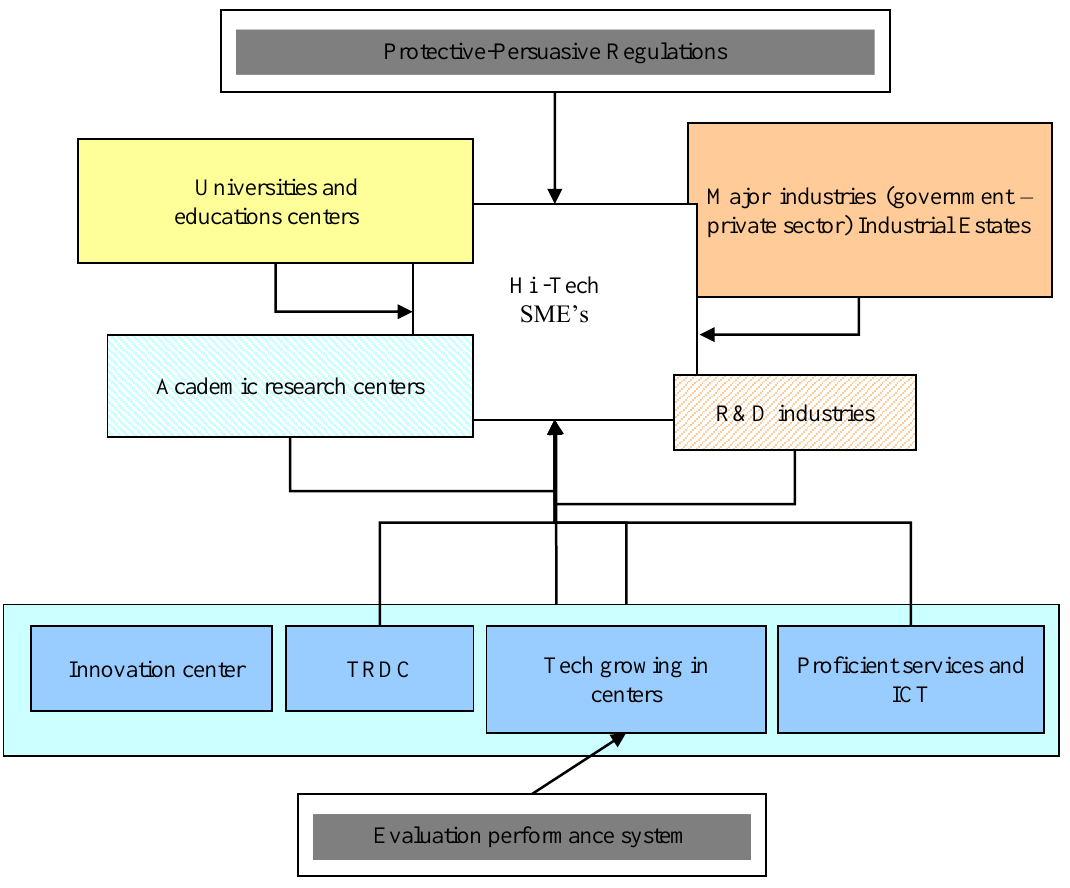
Figure 1. Interaction of key elements of parks and technology incubators centers, with knowledge based SME’s which are located in the